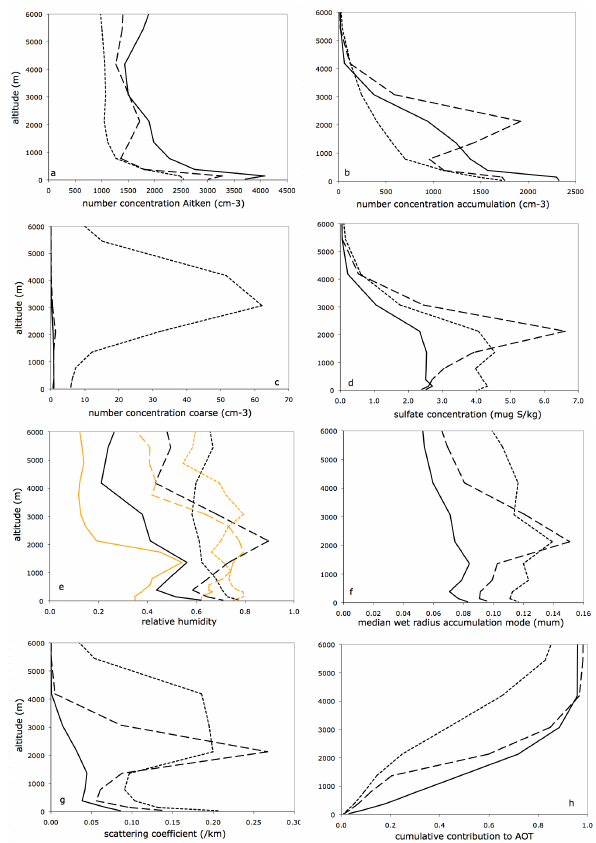
Figure 7. Simulated profiles of number concentrations of a) the Aitken, b) accumulation, and Fig. 7. Simulated profiles of number concentrations of (a) the c) coarse mode aerosol (kg -1 ) , and of d) aerosol sulfate ( µ g S kg -1 ), e) RH (sonde Aitken, (b) accumulation, and (c) coarse mode aerosol (kg − 1 ) , and measurements in orange), f) median wet radius of the soluble accumulation mode ( µ m), g) the of (d) aerosol sulfate (µgSkg − 1 ) , (e) RH (sonde measurements in scattering coefficient (km -1 ) and h) the scaled cumulative optical thickness profile, for the dry orange), (f) median wet radius of the soluble accumulation mode (May 7-12, solid line), moist (May 22-26, dashed) and dust periods (May 27-30, dotted). (µm), (g) the scattering coefficient (km − 1 ) and (h) the scaled cumu- lative optical thickness profile, for the dry (7–12 May, solid line), moist (22–26 May, dashed) and dust periods (27–30 May,